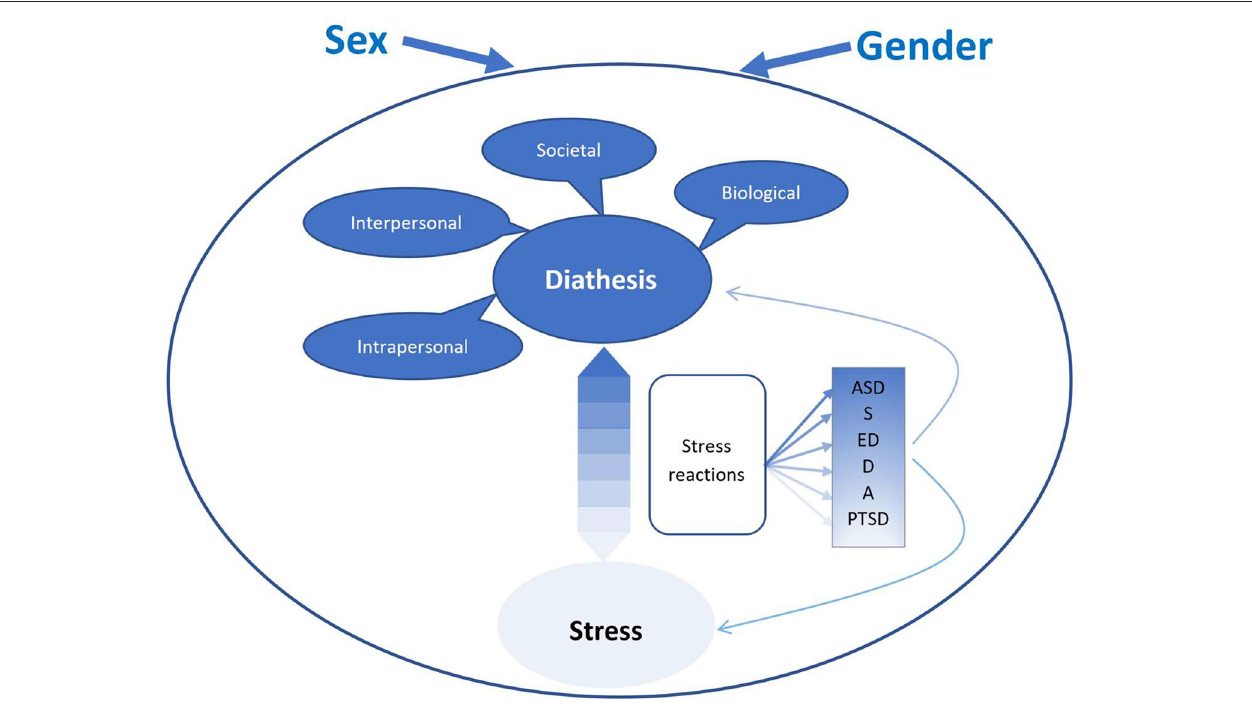
FIGURE 1 | A diathesis stress model of sex and gender differences in mental disorders. ASD, autism spectrum disorder; S, schizophrenia; ED, eating disorders; D, depression; A, anxiety; PTSD, posttraumatic stress disorder. The differences in shading represents a shift in the diathesis vs. stress balance for the different disoders.